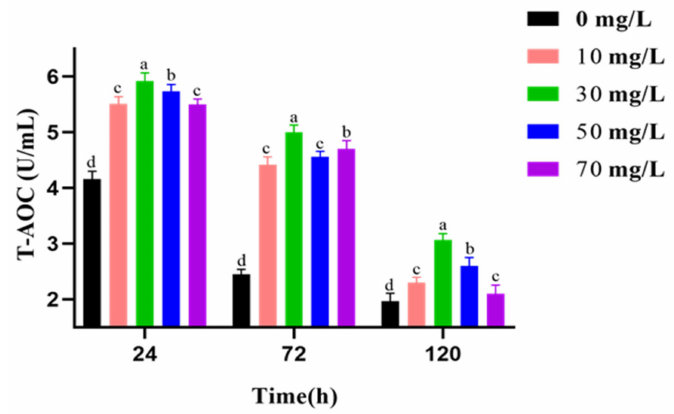
Figure 1. E ff ect of grape seed procyanidin extracts (GSPE) on the total antioxidative capacity (T-AOC) of goat sperm of preserved at 4 ◦ C. Within the same incubation time, values with di ff erent superscripts di ff er among treatments ( p < 0.05). The values are expressed as mean ± SEM.